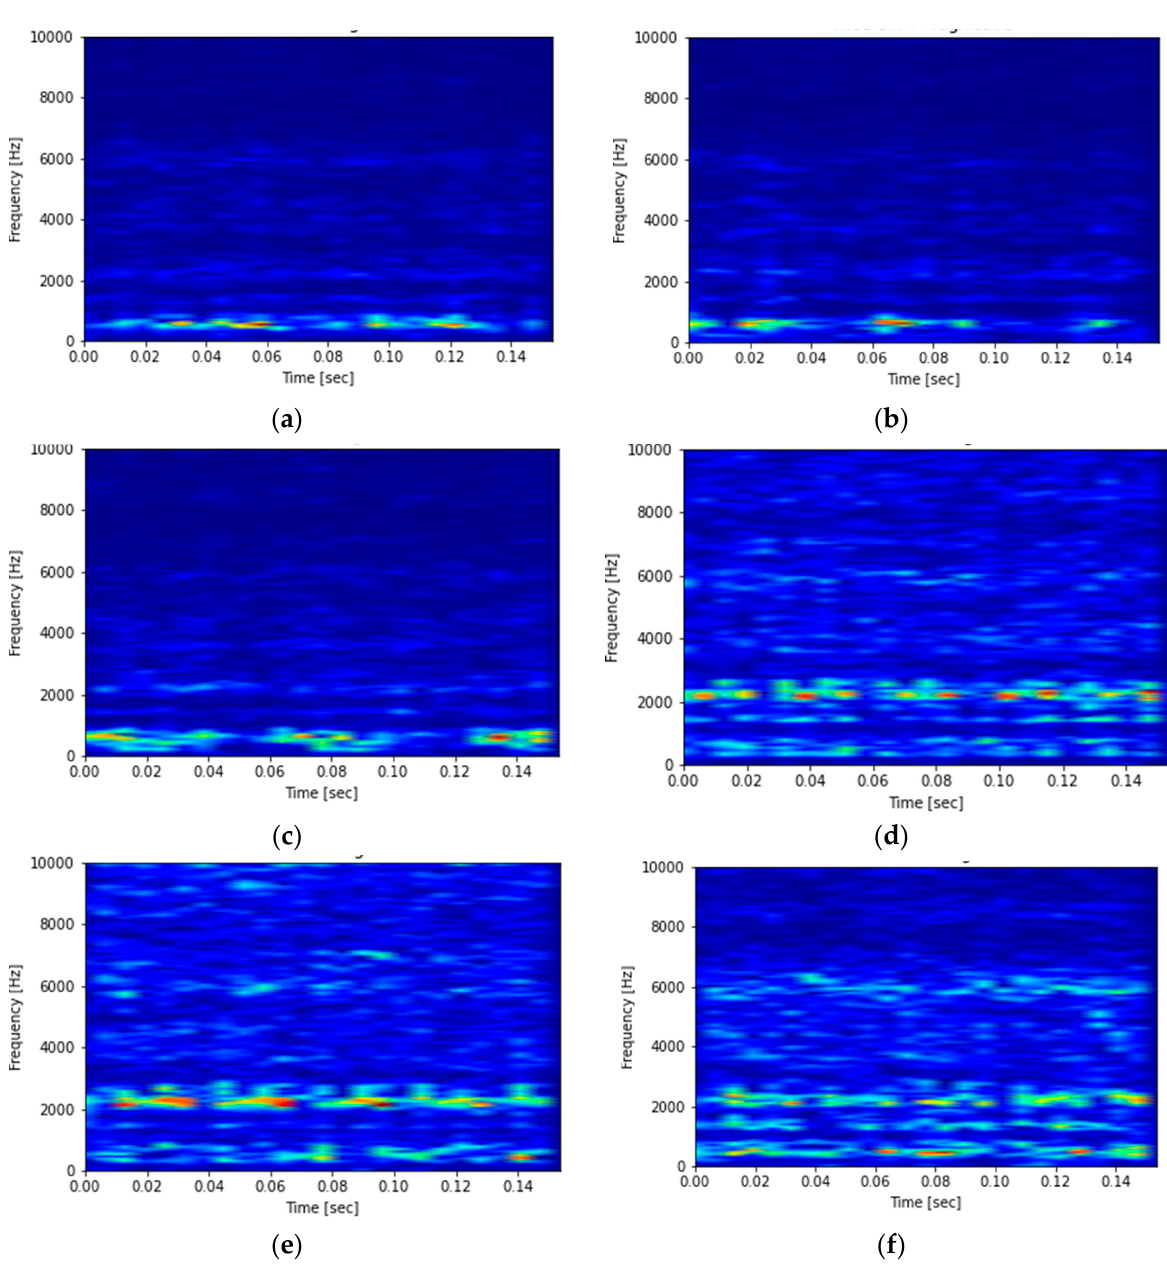
Figure 3. STFT Spectrogram representing various tool conditions.